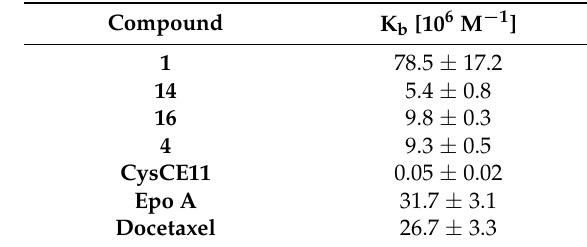
Table 1. Binding constants of epothilone analogs 1 , 14 , and 16 and of epothilone-CE11 conjugate 4 for stabilized microtubules 1 .